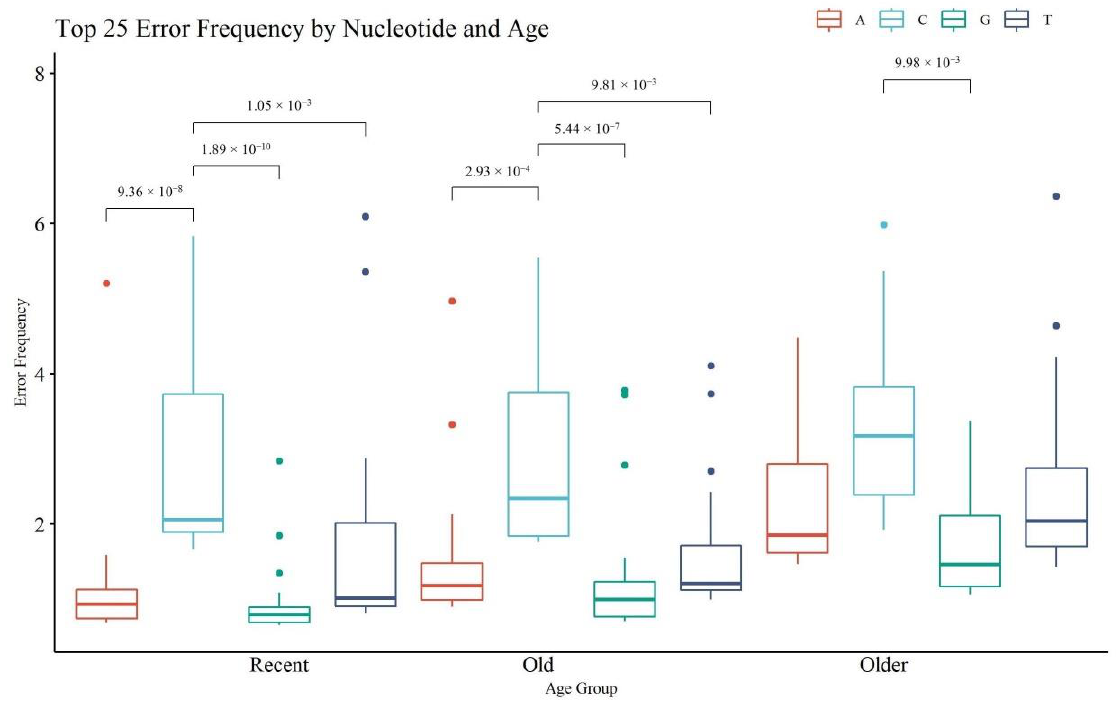
Figure 11. Boxplots of noise for the top 25 nucleotide positions, per nucleotide type (A, C, G, T), and per age. Brackets show comparisons with significant p -values ( p < 0.05) within each age